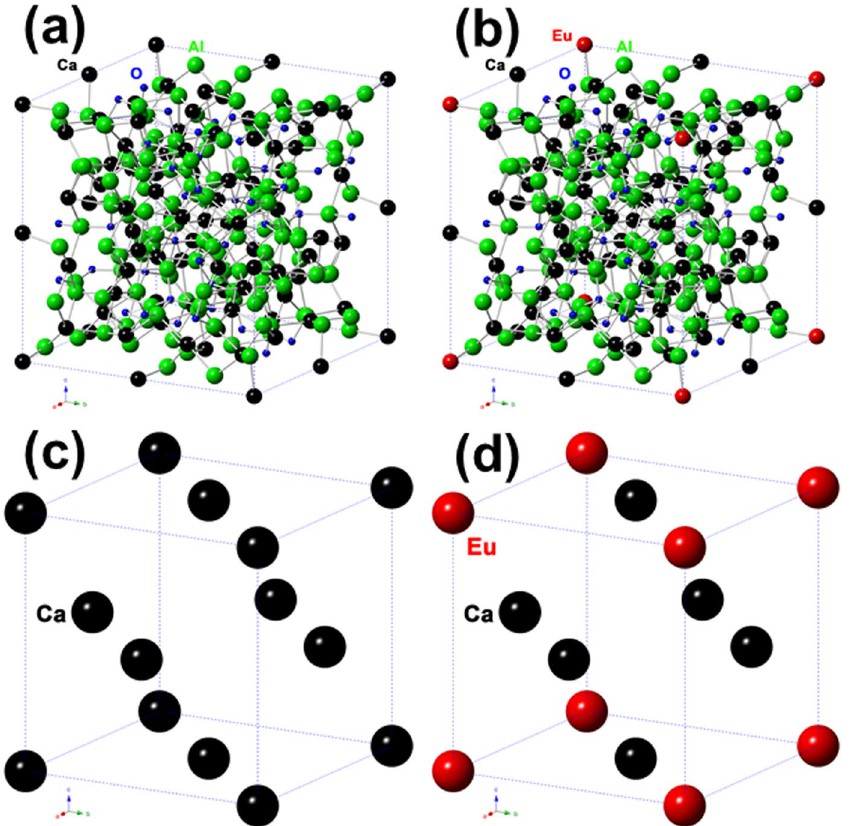
Figure 4. The schematic diagram of parts of Ca replaced by Eu in the unit cell of Ca 9 A l6 O 18 phase. ( a ) Original unit cell structure of Ca